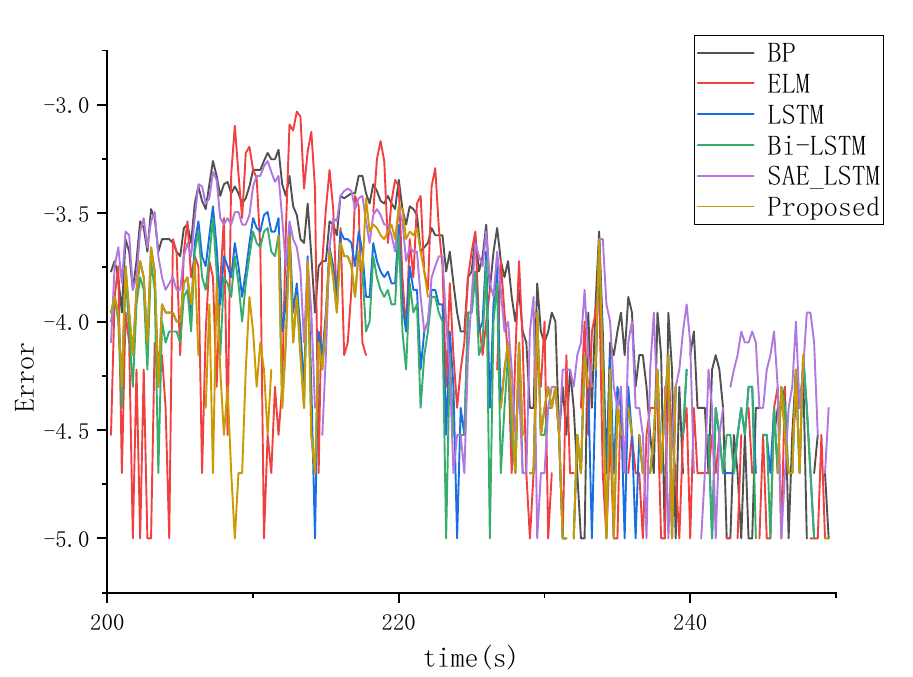
Figure 21. Pitch angle prediction error results in the testing set of Dataset 1.